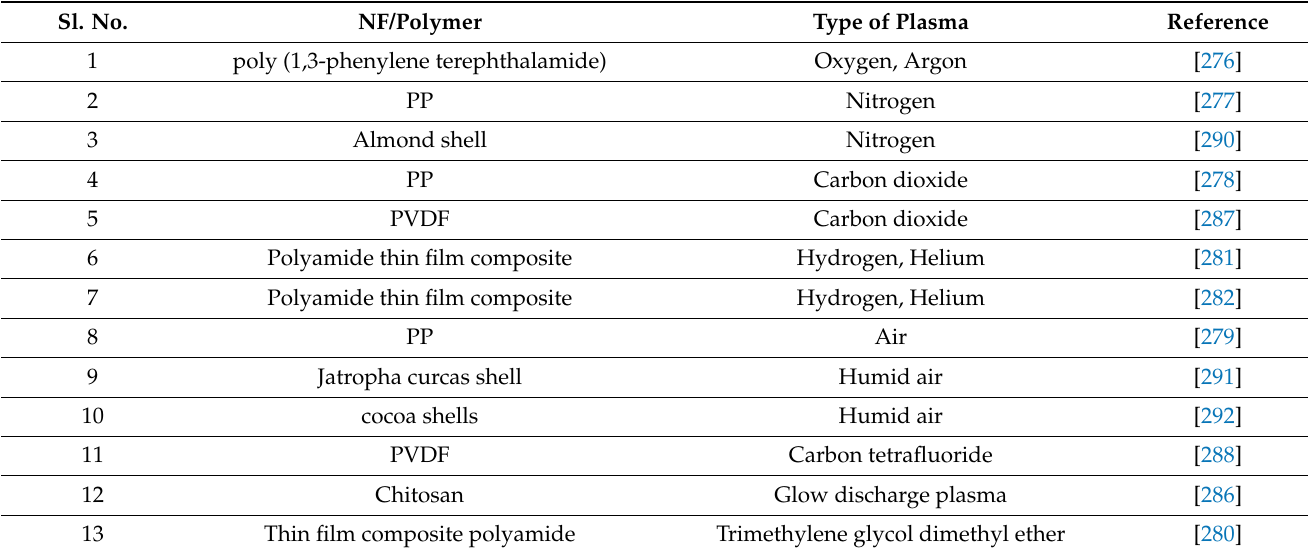
Table 6. Reported some studies of plasma-treated polymers for water